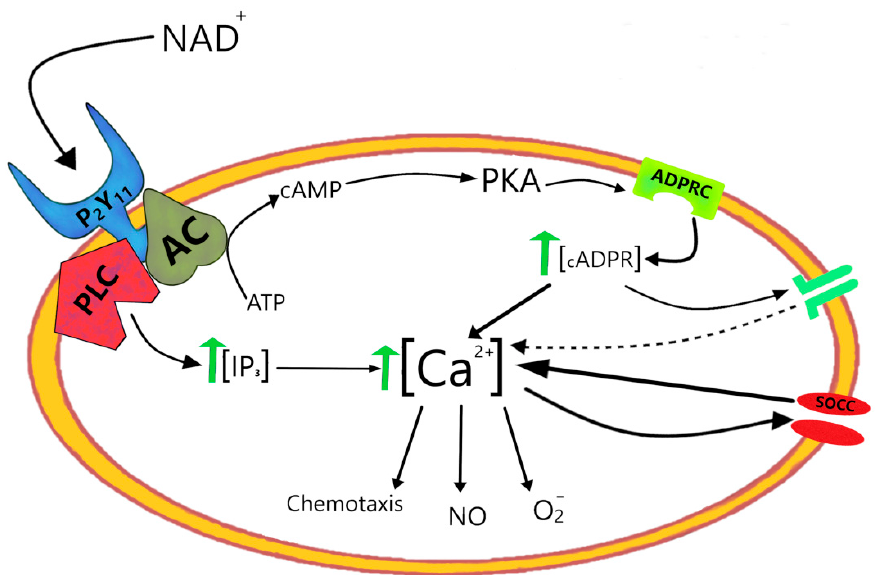
Figure 9. Dual roles of NAD + as an agonist of P2Y11 purinergic receptor and a cADPR precursor for the [Ca 2+ ] i -mediated mechanisms of granulocyte activation. PLC, Phospholipase C; AC, Adenylyl cyclase; ADPRC, ADP-ribosyl cyclases; SOCC, Store-operated calcium channels.